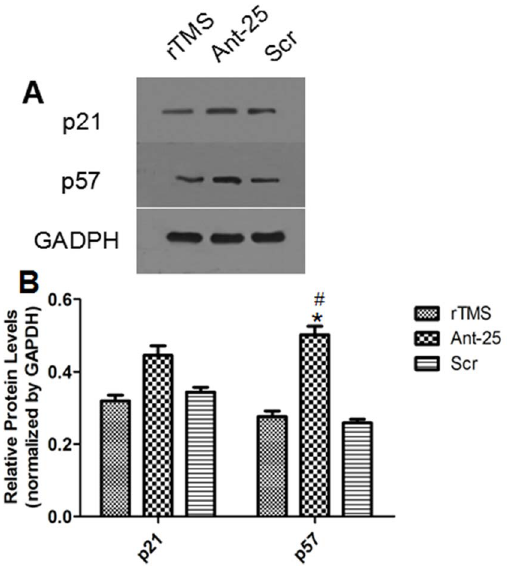
Figure 8. Effects of Ant-25 and Scr on p21 and p57 in the ischemic cortex 7 days after surgery. (A) Electrophoresis of p21, p57 and GAPDH on gel. (B) Relative levels of p21 and p57 protein from the different groups. # P =0.018 compared to the rTMS group;